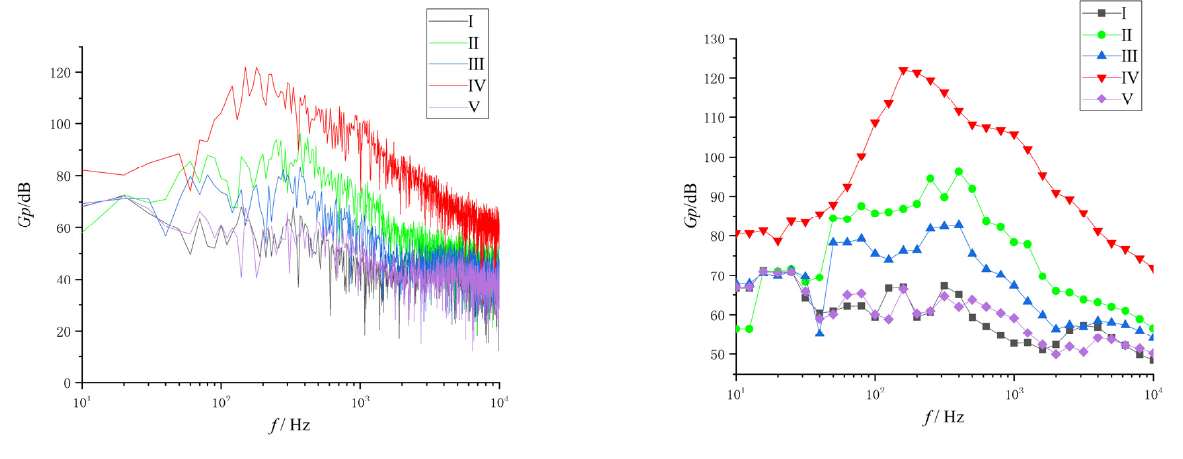
Figure 17. The self-power spectral of the pressure fluctuation at the velocity of 12 kn.